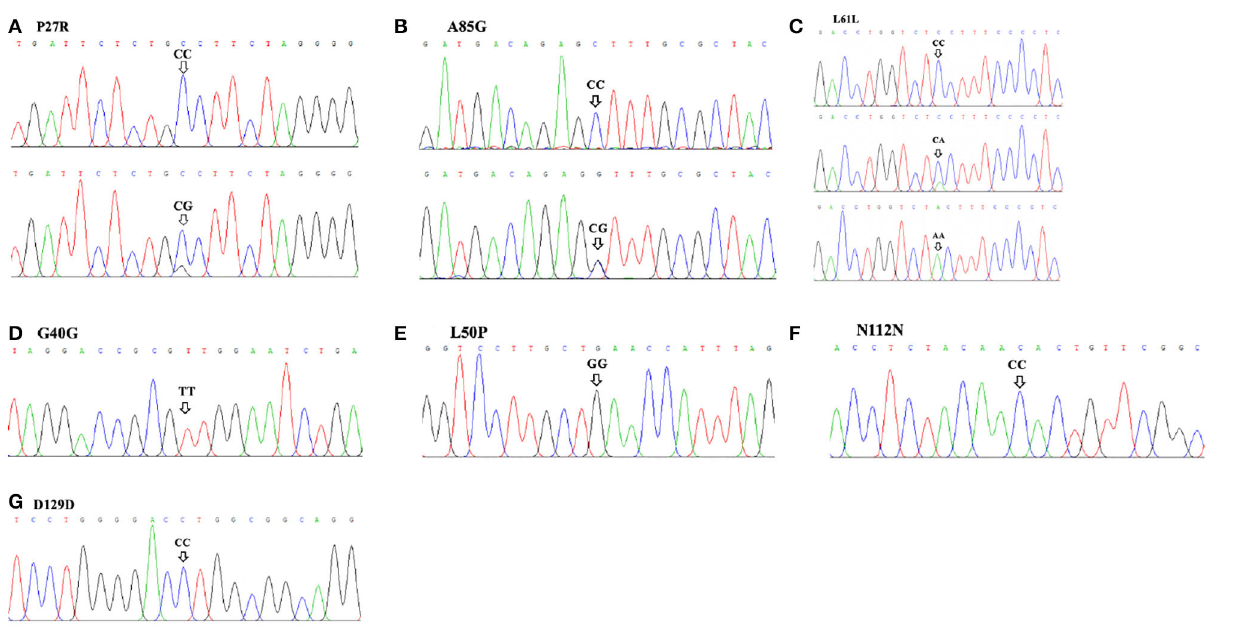
Frontiers in Veterinary Science |